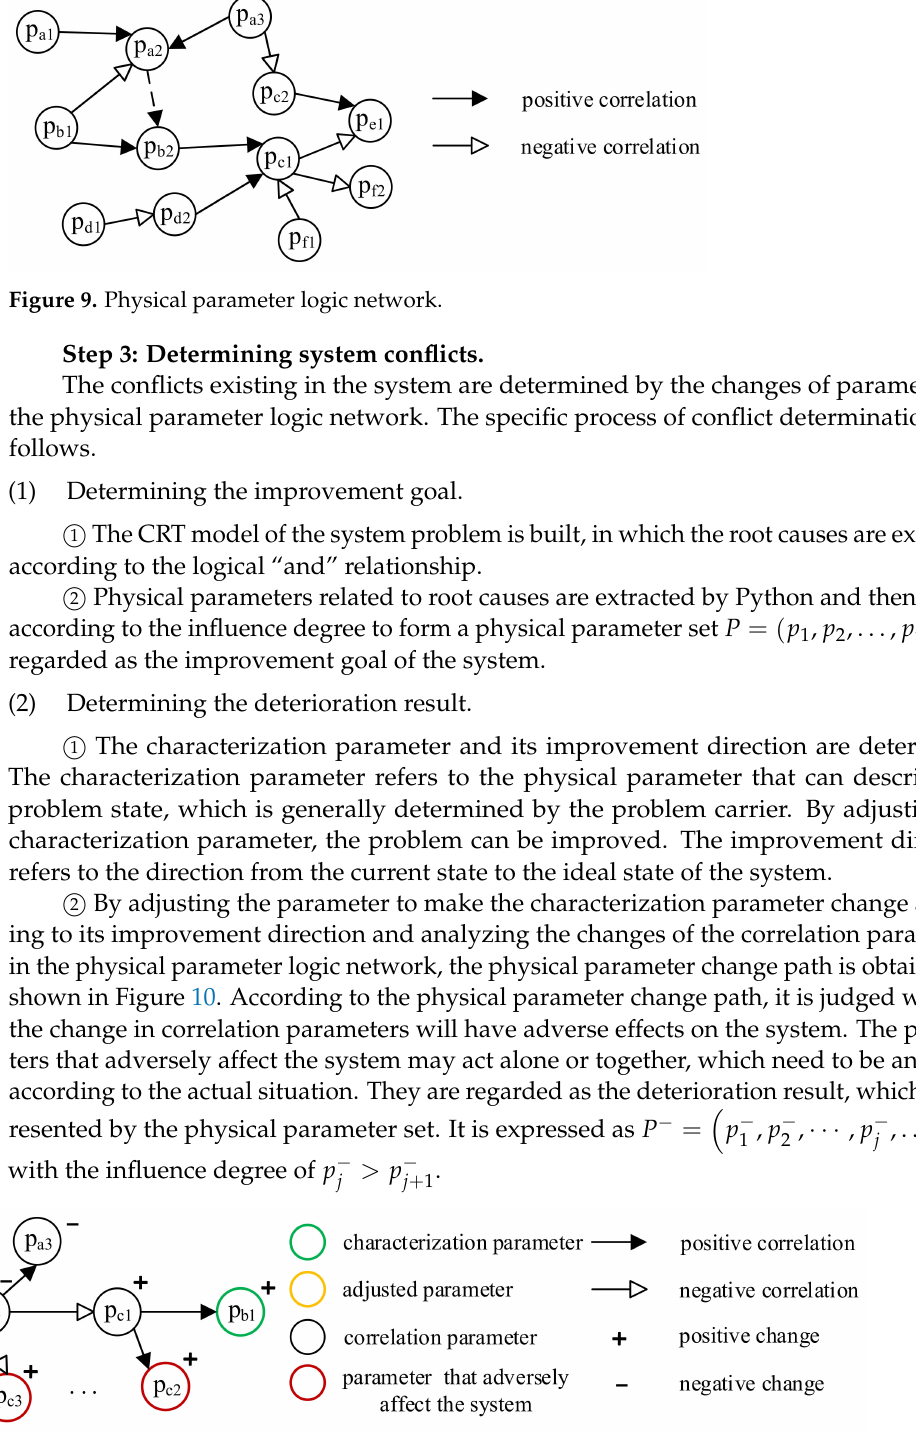
Figure 10. Physical parameter change